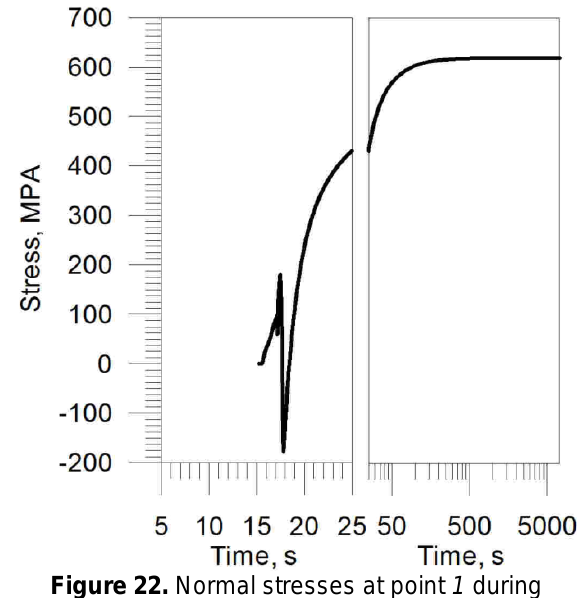
Figure 22. Normal stresses at point 1